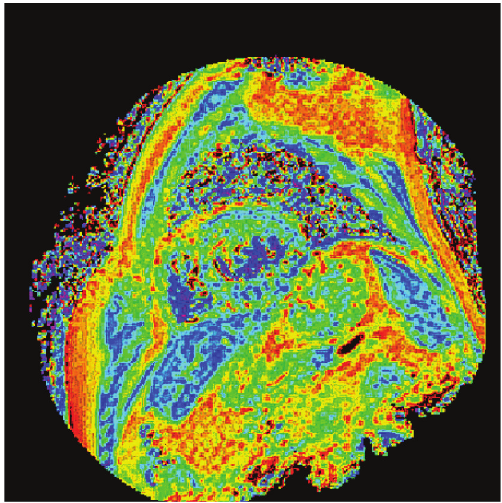
Figure 1: Myocardial T2 mapping generated from multiecho T2- weighted